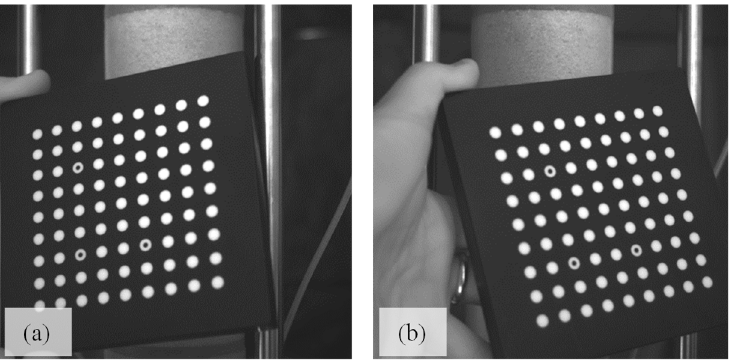
Figure 2. Camera calibration grid as captured in the left ( a ) and right image ( b ).